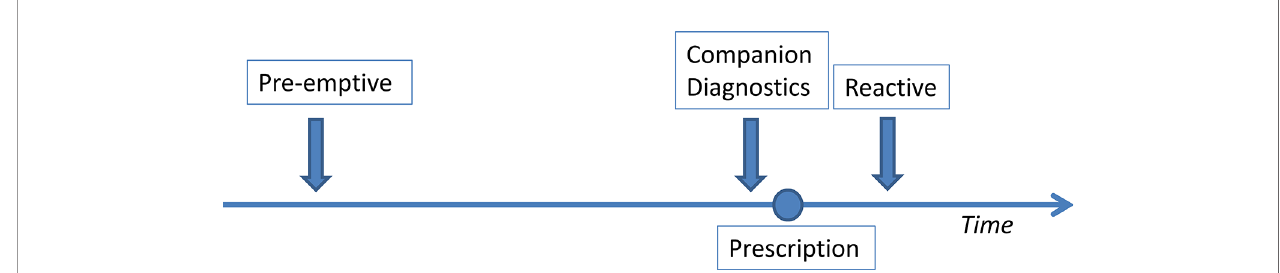
FIGURE1 | Possible timing of pharmacogenetic testing in relation to